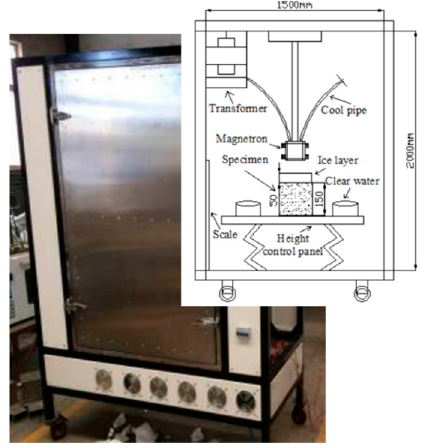
Figure 4. Microwave deicing test device.